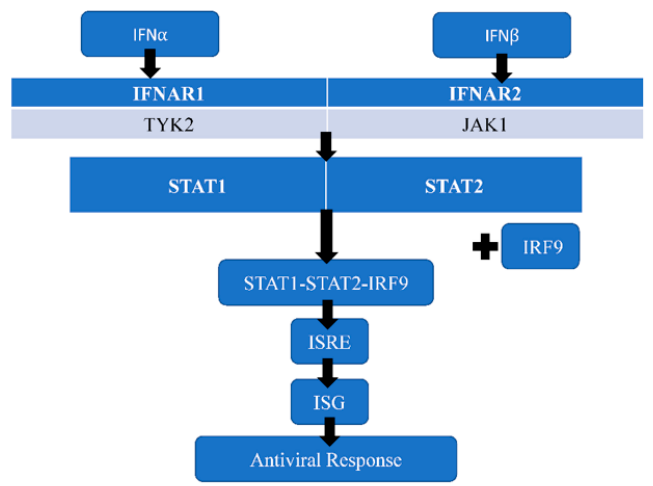
Figure 3. IFN α / β generates the antiviral response to control ZIKV infection. IFN α ∶ Interferon